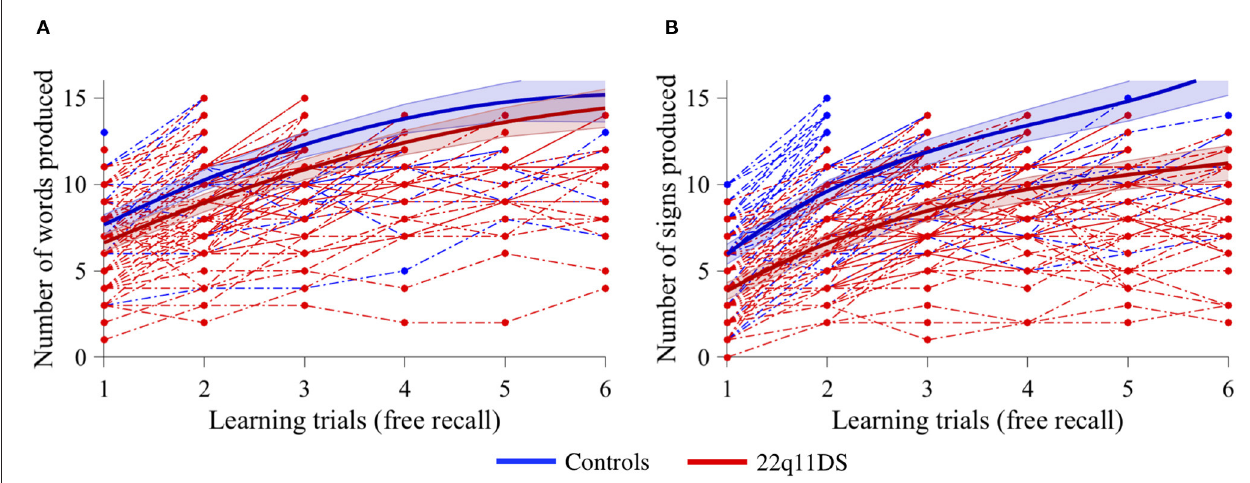
FIGURE 2 | Comparison of learning curves between 22q11DS (displayed in red) and controls (displayed in blue) with age as a covariate for (A) verbal information acquisition and (B) non-verbal information